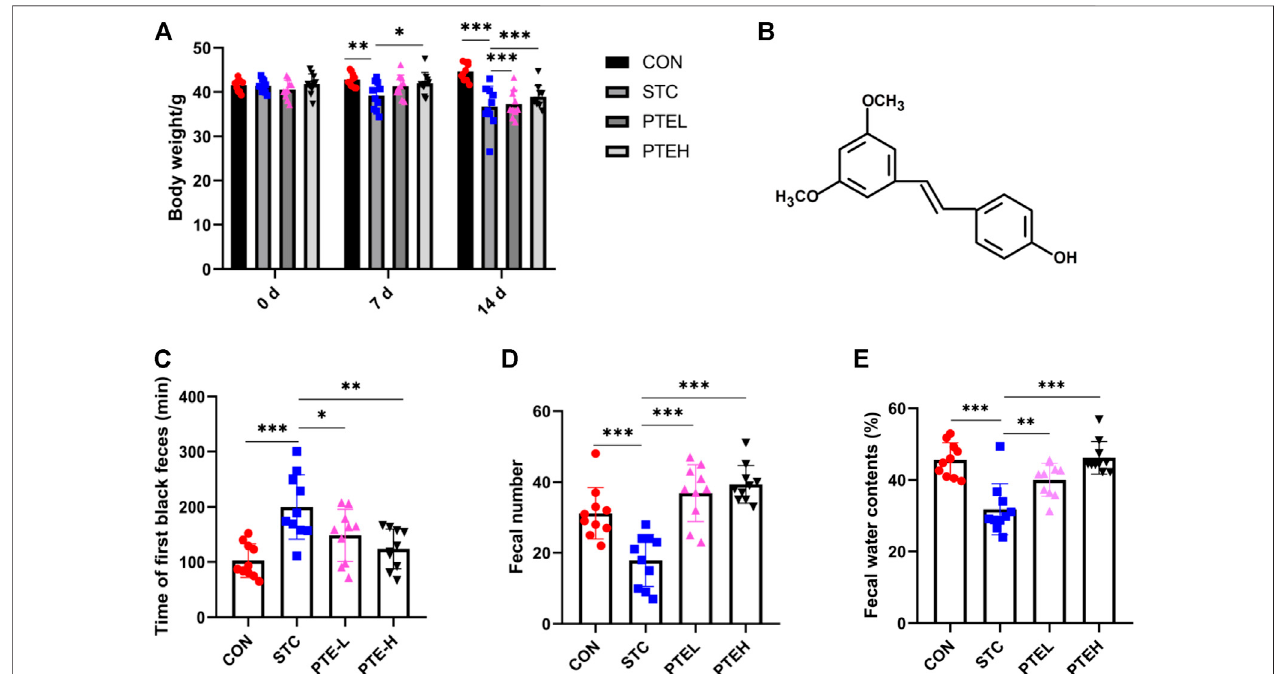
FIGURE1| PTEalleviatedLOP-inducedconstipationsymptoms. (A) Bodyweight. (B) ChemicalstructureofPTE.Fecalparameters: (C) Thewholeguttransittime. (D) Fecal number. (E) Water contents. ( n = 10). * p < 0.05, ** p < 0.01, *** p < 0.001. (LOP, loperamide; STC, slow transit constipation; PTE, pterostilbene).